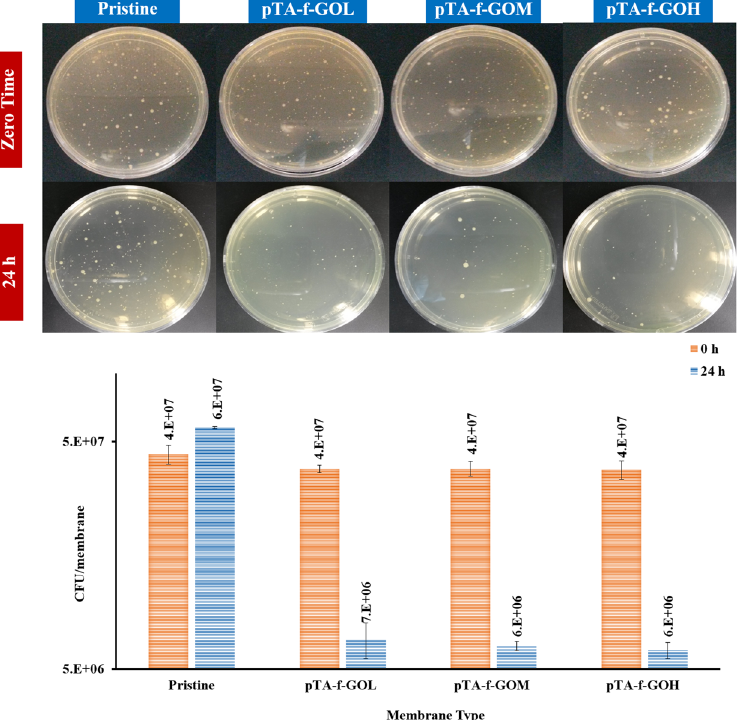
Figure 6. The biocidal activity of the pristine and pTA-f-GO TFNC fabricated membranes as a function of GO